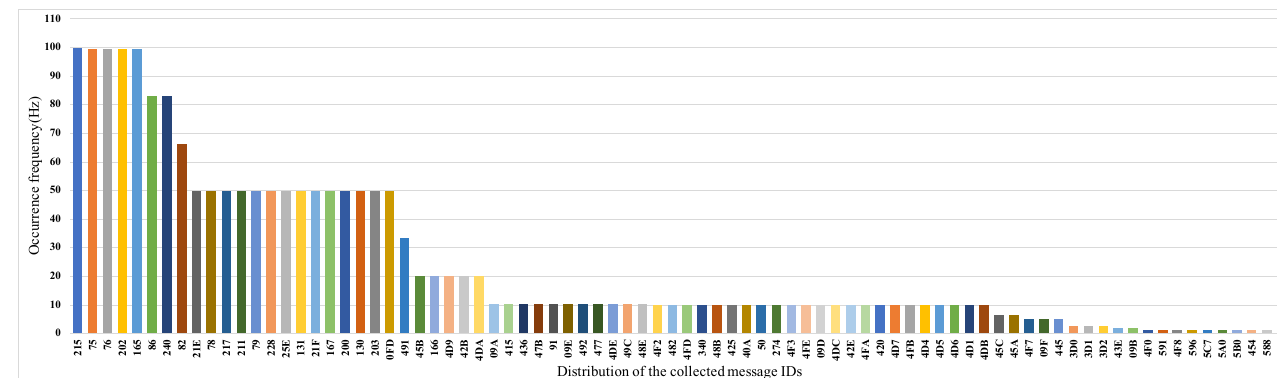
Figure 10. CAN message frequency distribution.